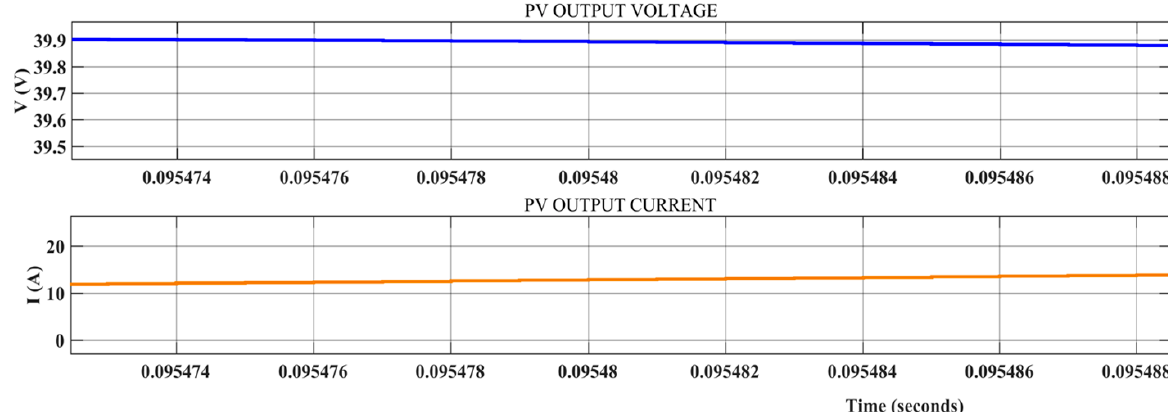
Figure 9. Output voltage and current from the PV to feed the converter. The battery was charged during bidirectional mode through the switch S 4 . Figure 10 shows battery state of charge (SOC), with a battery voltage of 45 V and a current of − 2 A in bidirectional mode. It should be noted that since the SOC of battery changes, the bat- tery current falls immediately and again increases within a very shorter time.